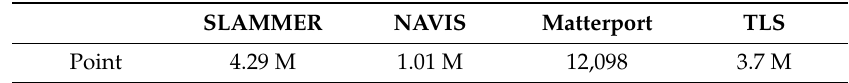
Table 6. The number of point for the three different indoor mapping solutions utilized for the accuracy